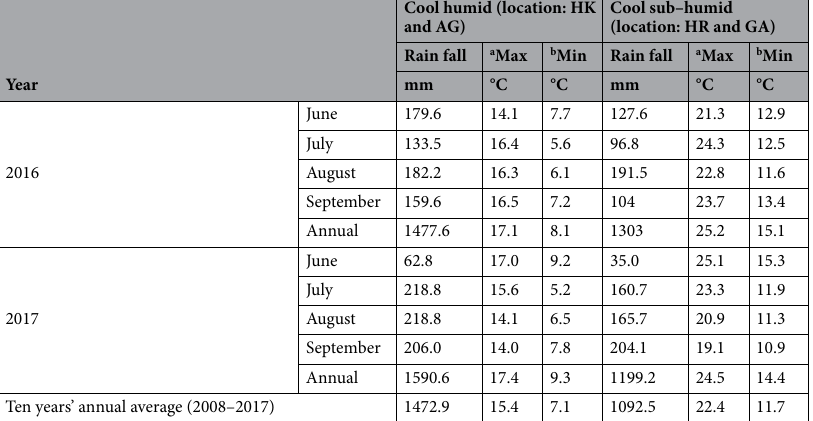
Table 1. Annual average rainfall, mean maximum and minimum temperatures during the study period. a Max Maximum temperature. b Min Minimum temperature, HM Hankomolicha, AG Abala Gase, HR Haranfama, GA Gike